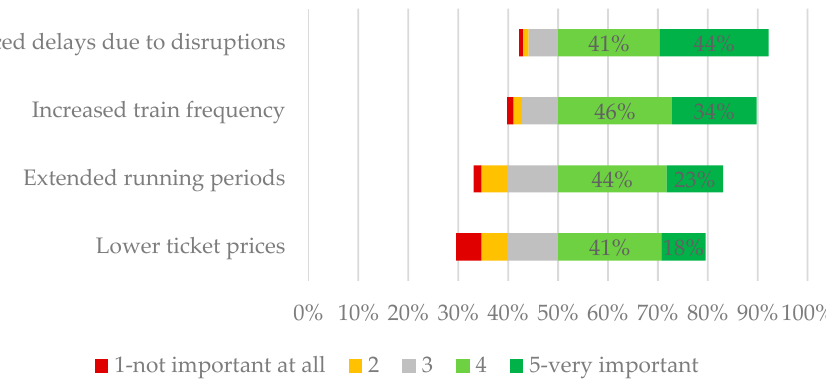
Figure 5. Factors that would influence passengers for considering teleoperation as preferred option.